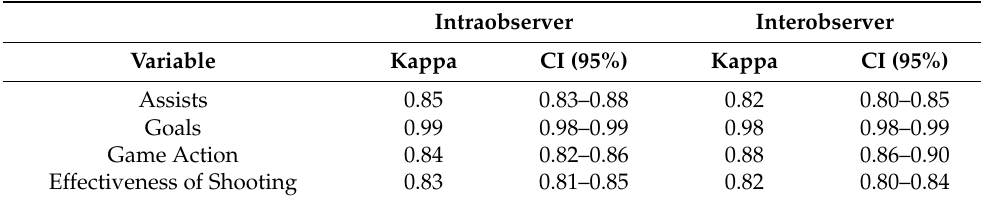
Table 1. Kappa values for intraobserver and